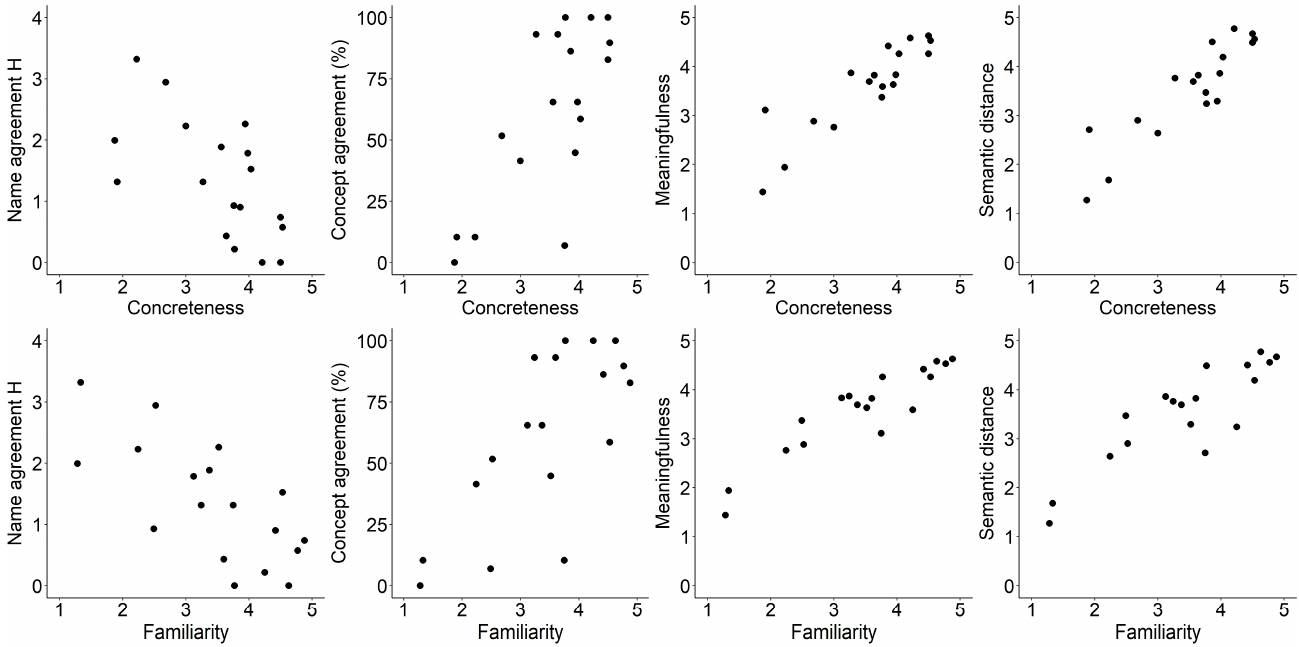
Figure 5. Scatterplots with concreteness and familiarity on the x-axes, and name agreement H , concept agreement, meaningfulness and semantic distance on the y-axes.